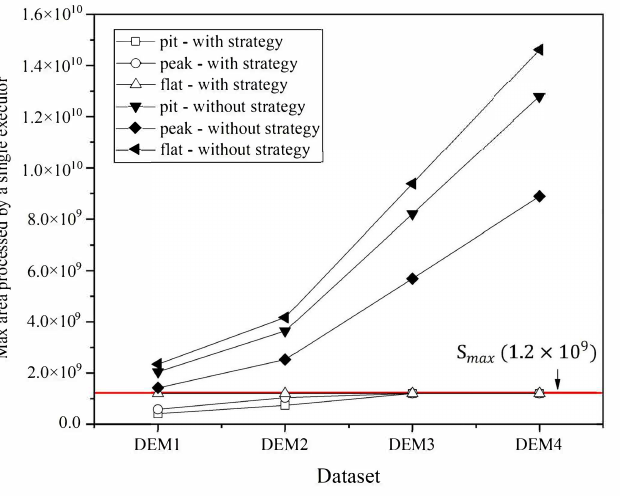
Figure 12. Comparisons of max area statistics processed by a single executor with or without the multi-level data decomposition strategy.